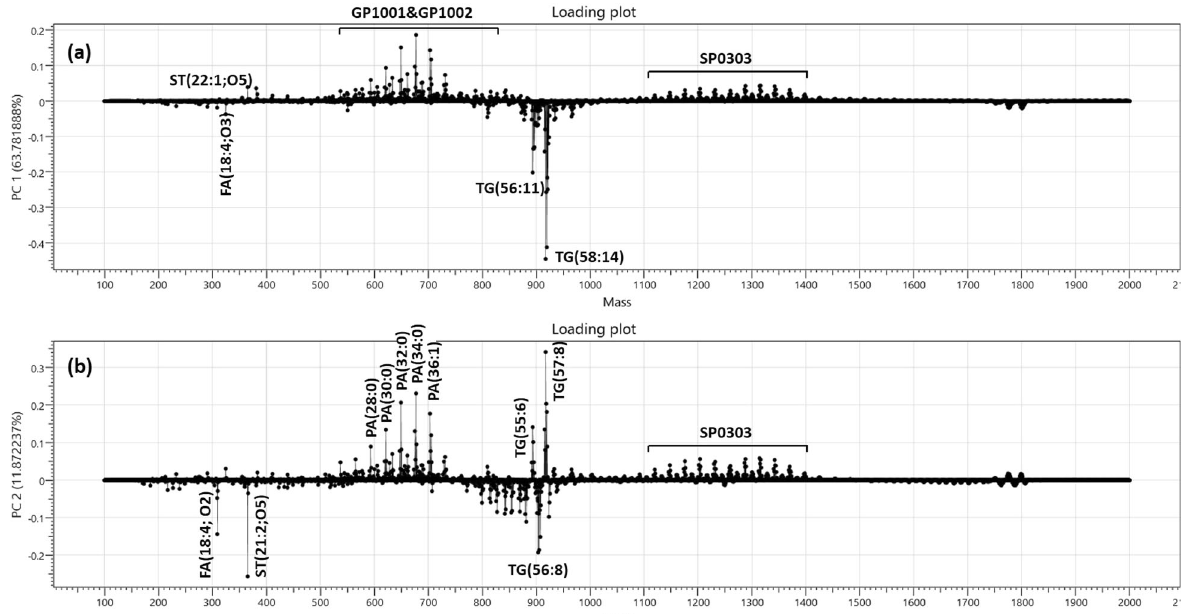
Fig. 5 The principal component loading plot shows the separation between different milk species. a First principal component loading plot, b second principal component loading